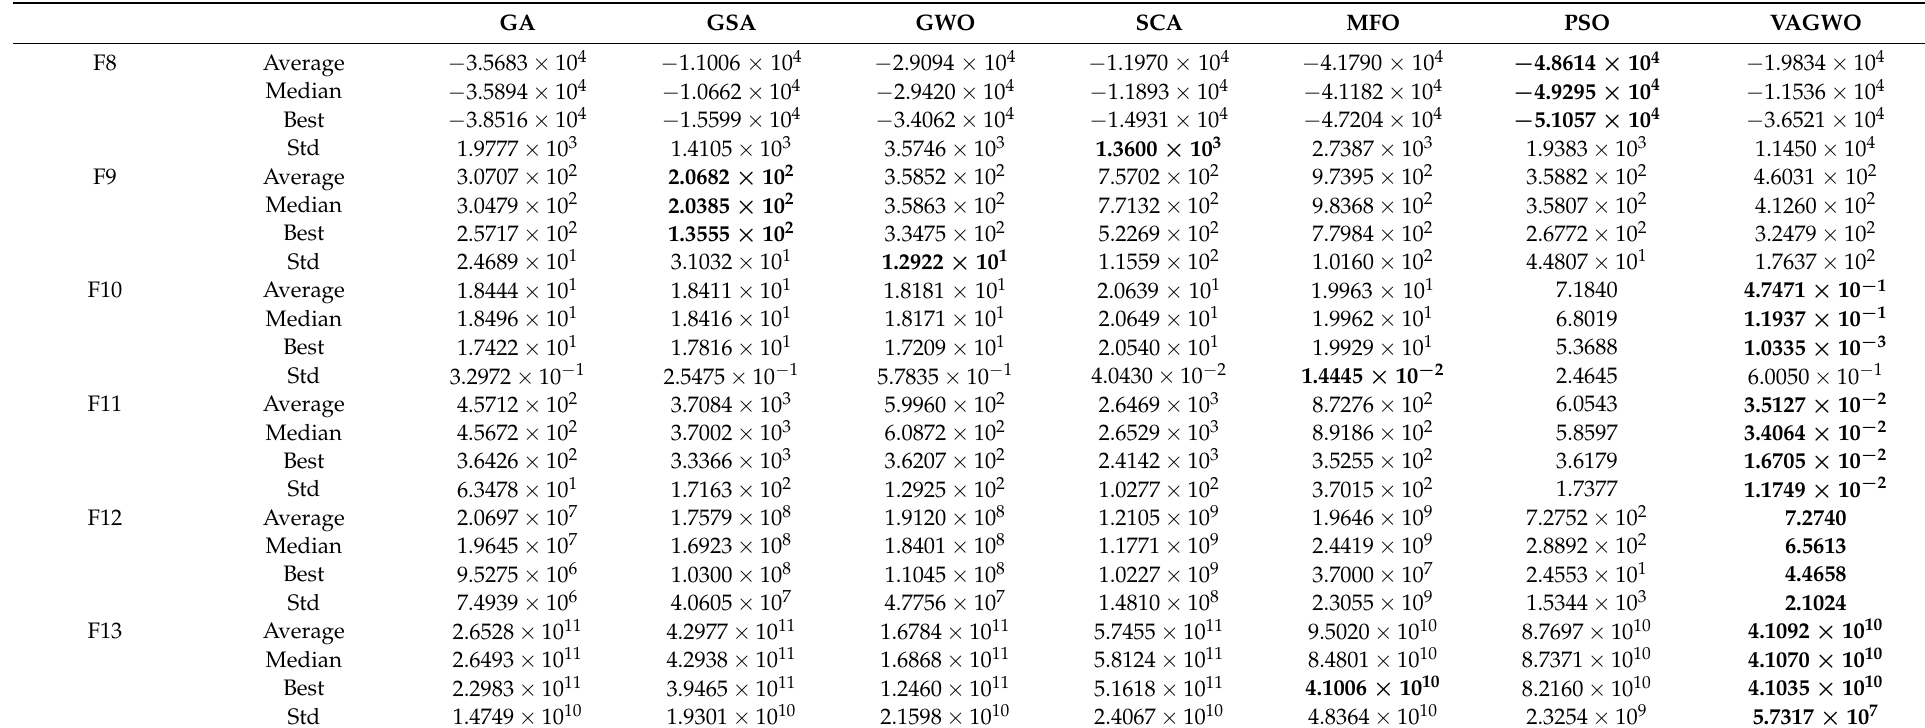
Table 3. The results achieved by the VAGWO against the popular algorithms for the multi-modal functions at D =